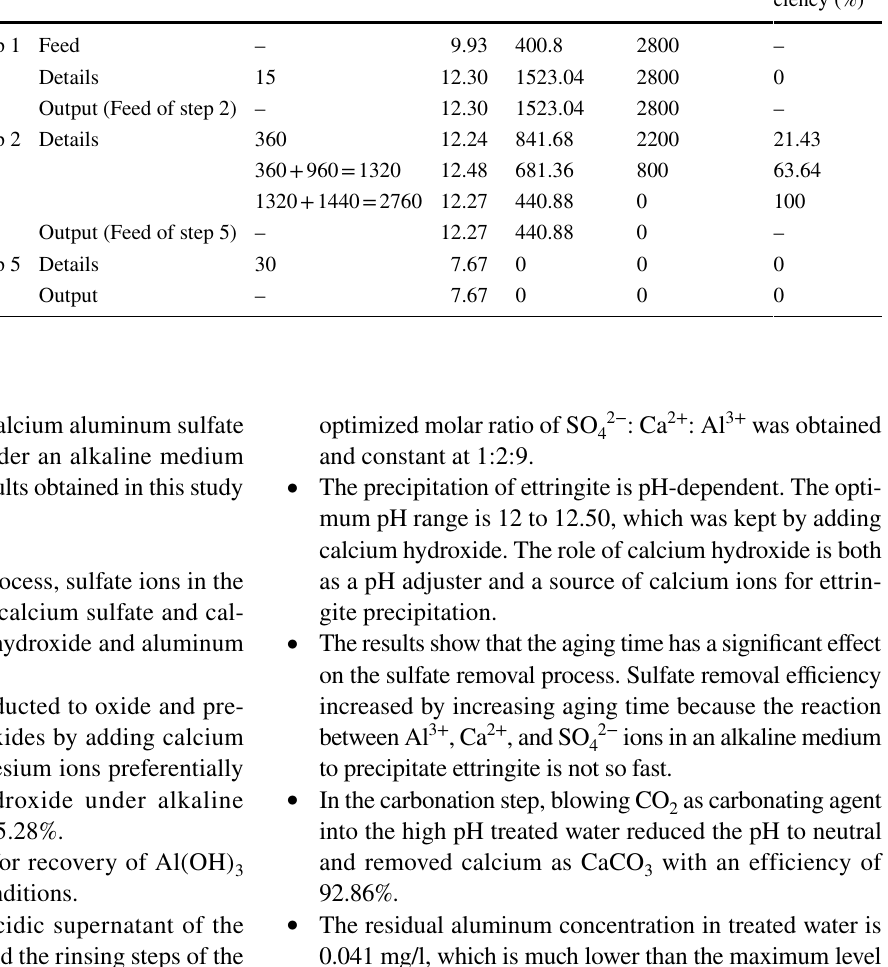
Table 7 Results of steps first, second, and fifth of the ettringite precipitation process with recovered aluminum